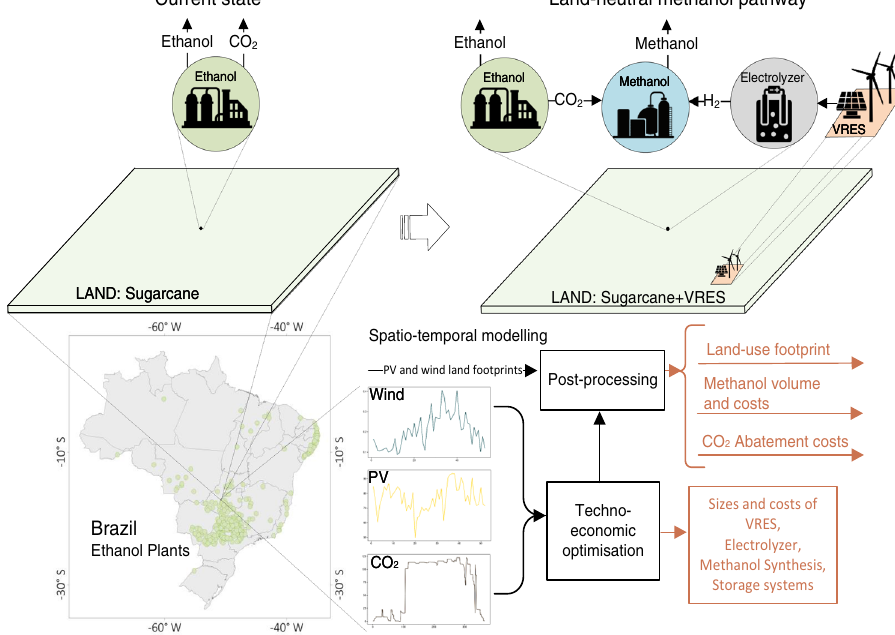
Fig. 1 The proposed land-neutral methanol pathway. The left top side presents the current state of fuel production at sugarcane ethanol plants, while the right top shows the new system con fi guration under the pathway. The bottom of the fi gure shows how Brazilian-speci fi c data on the Brazilian sugarcane ethanol industry and solar and wind resource estimations are combined to assess the proposed